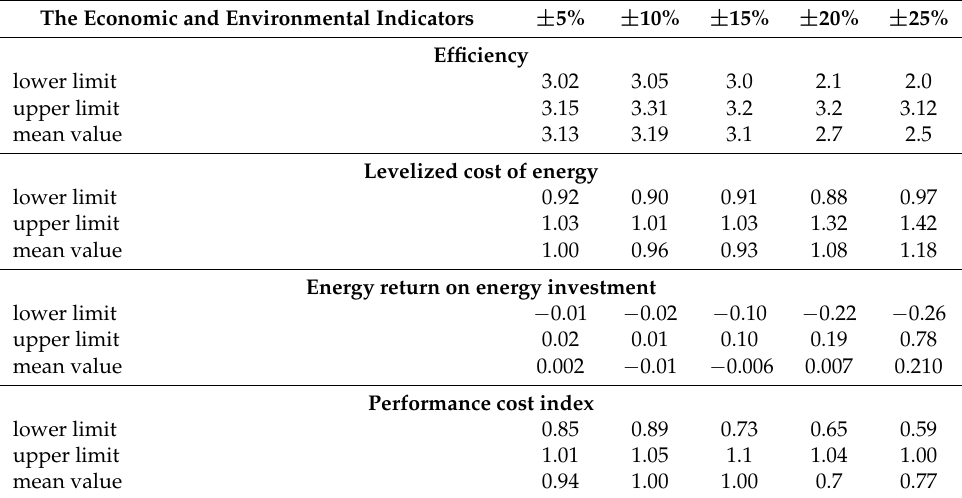
Table 2. Confidence intervals and the mean corresponding to the